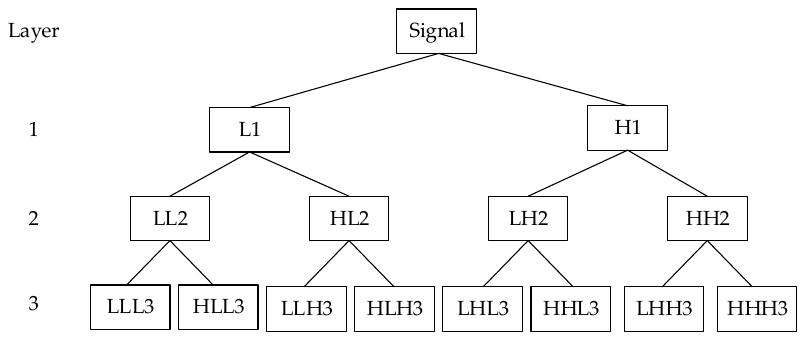
Figure 6. Wavelet packet 3-layer decomposition tree.